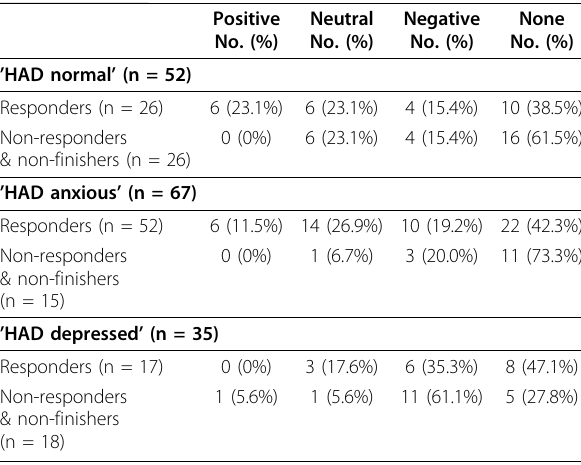
Table 2 Response to hypnotherapy and mood color choice in ‘ HAD normal ’ , ‘ HAD anxious ’ and ‘ HAD depressed ’ patients (pre-HT)